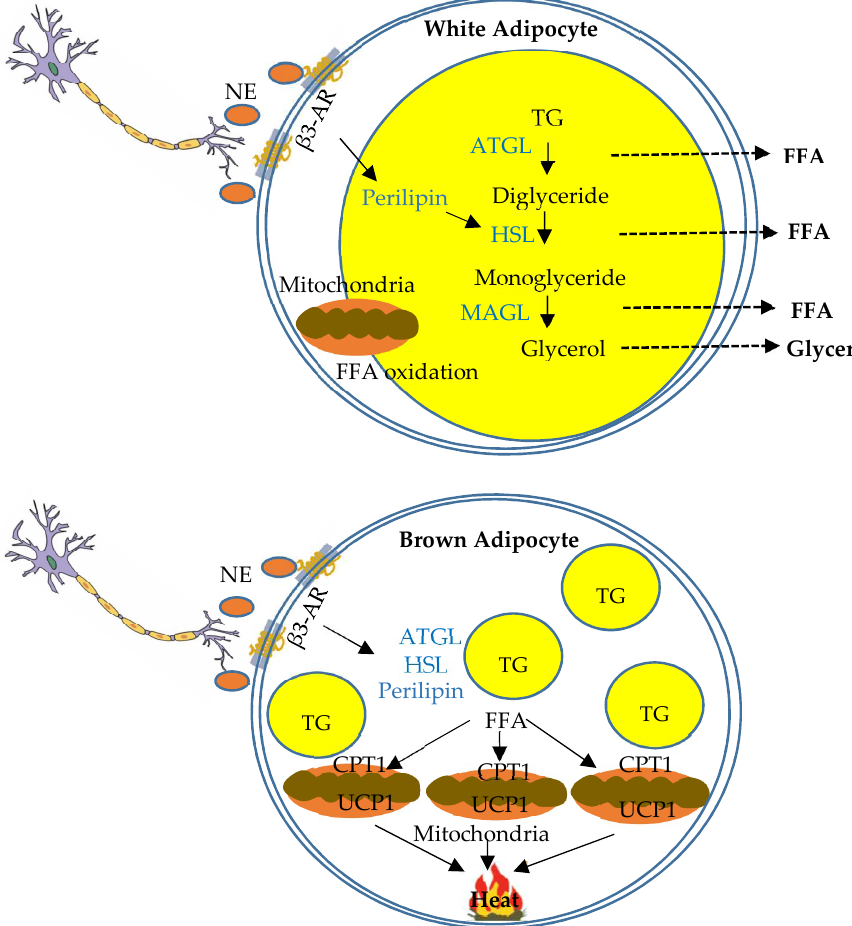
Figure 3. Schematic overview of function of sympathetic innervation of white and brown adipose tissues in the regulation of lipid metabolism. Schematic diagram indicating lipolysis and thermogenesis in white and brown adipocytes respectively regulated by sympathetic innervation. In white adipocytes, sympathetic innervation regulates a cascade of lipolysis to convert stored triglycerides (TG) to free fatty acids (FFA) and glycerol that can be used as fuels of other tissues. In brown adipocytes, sympathetic innervation regulates non-shivering thermogenesis. FFAs are transferred into mitochondria, primarily by carnitine palmitoyltransferase 1 (CPT1), and serve as fuel for β-oxidation. UCP1 is activated to disassociate respiratory chain from ATP production, and ultimately dissipates energy as heat.